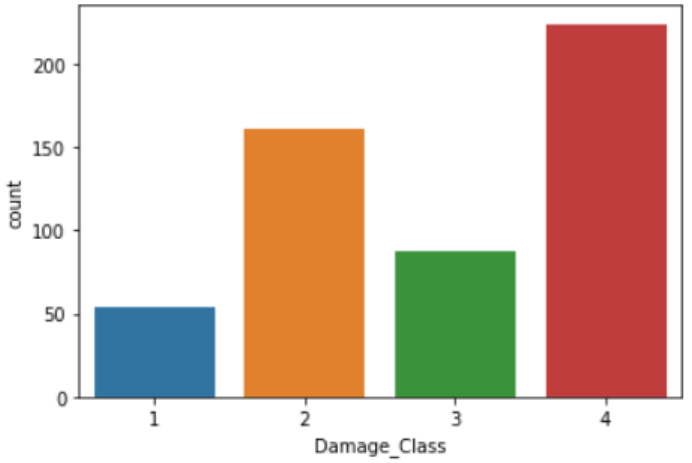
Figure 4. The damage class distribution of studied